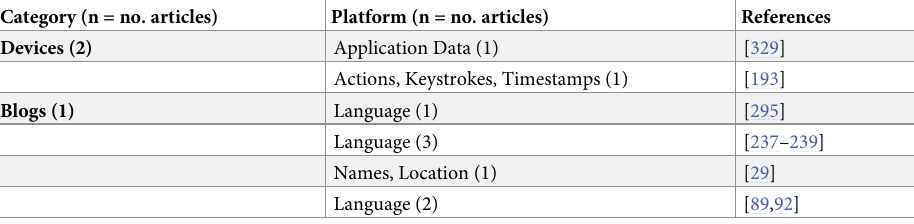
Table 20. Number of articles predicting language, with associated predictors and references.